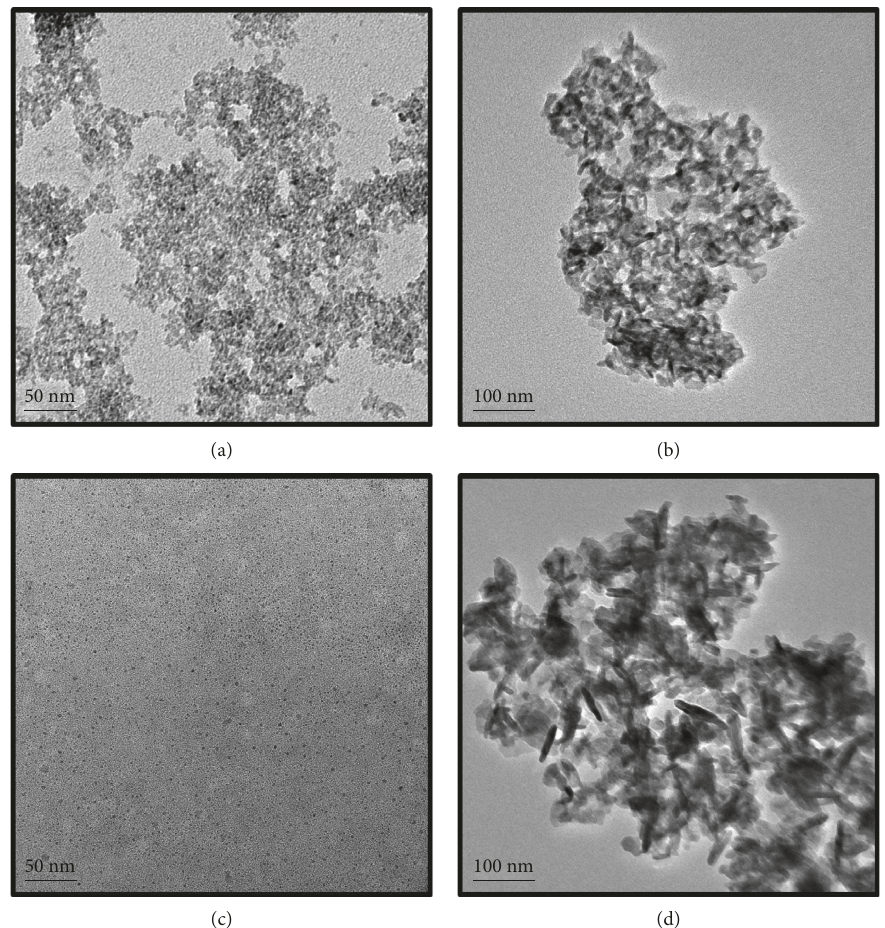
Figure 4: TEM images of (a) L -alanine-capped ZnS, (b) L -alanine-capped CuS, (c) L -aspartic acid-capped ZnS, and (d) L -aspartic acid- capped CuS